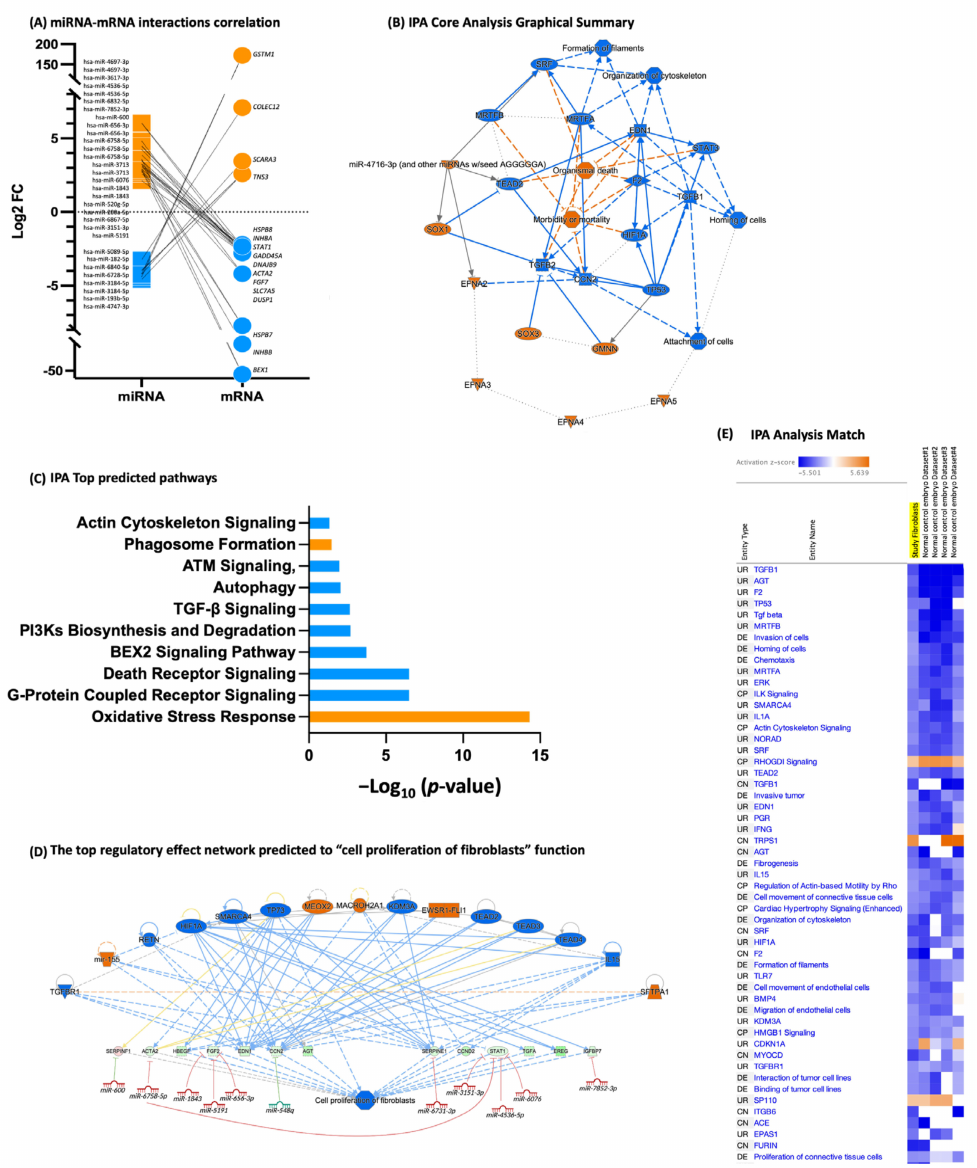
Figure 4. miRNA–mRNA interactions and predicted pathways in fibroblasts with high reprogram- ming efficiency. ( A ) miRNA-mRNA interactions correlation. ( B ) Graphical summary of the major biological themes (canonical pathways, upstream regulators, diseases, and biological functions) in the IPA Core Analysis to illustrate how those concepts relate to one another. Predicted canonical pathways encoding homing of cells, organization of the cytoskeleton, cell death, and survival are shown. The genes shaded in orange are upregulated and those that are blue are downregulated. ( C ) A bar graph of the top predicted pathways; orange bars correspond to upregulated pathways and blue to the downregulated ones. ( D ) The top regulatory effect network predicting the “cell proliferation of fibroblasts” function. The genes shaded in orange or red are upregulated and those that are blue or green are downregulated. The intensity of the shading shows to what degree each gene was up- or down-regulated. A solid line represents a direct interaction between the two gene products and a dotted line represents an indirect interaction. ( E ) IPA Analysis Match in the context of over 100,000 IPA analyses to determine similarities with the most significant canonical pathways (CP), upstream regulators (ER), diseases and biological functions (DE) and causal network (CN). The activation z-score is a summary value that predicts the activation (positive value: orange) or inhibition (negative value: blue) of a CP, UR, or CN based on the gene expression